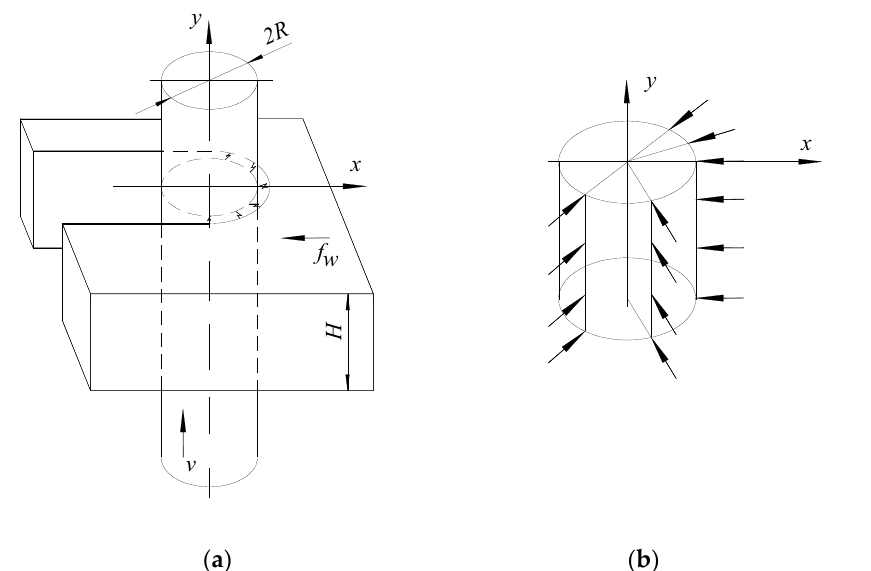
Figure 2. Generation of electric discharges only on half of the cylindrical surface of the wire electrode in the workpiece: ( a )—position of the wire in the slot; ( b )—electric discharges acting on half of the cylindrical surface of the wire electrode.